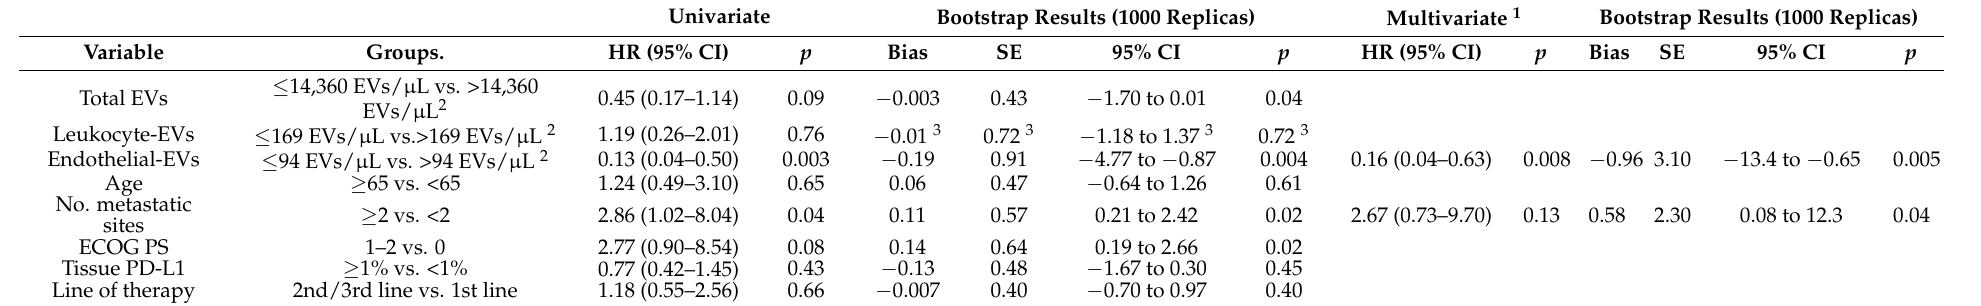
Table 1. Univariate and multivariate Cox proportional hazards regression analysis of survival in the immunotherapy cohort ( n = 32). Univariate Bootstrap Results (1000 Replicas) Bootstrap Results (1000 Replicas) Variable